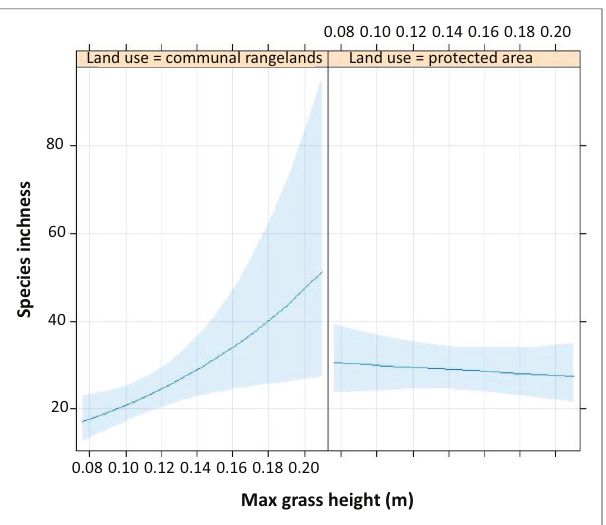
FIGURE 10-A1: Effects plot showing the relationship between avian abundance and maximum leaf table height (proxy for grass height). Abundances represent pooled abundances of both bird surveys conducted for each transect. Light shaded blue represents the 95 % confidence interval for the fitted